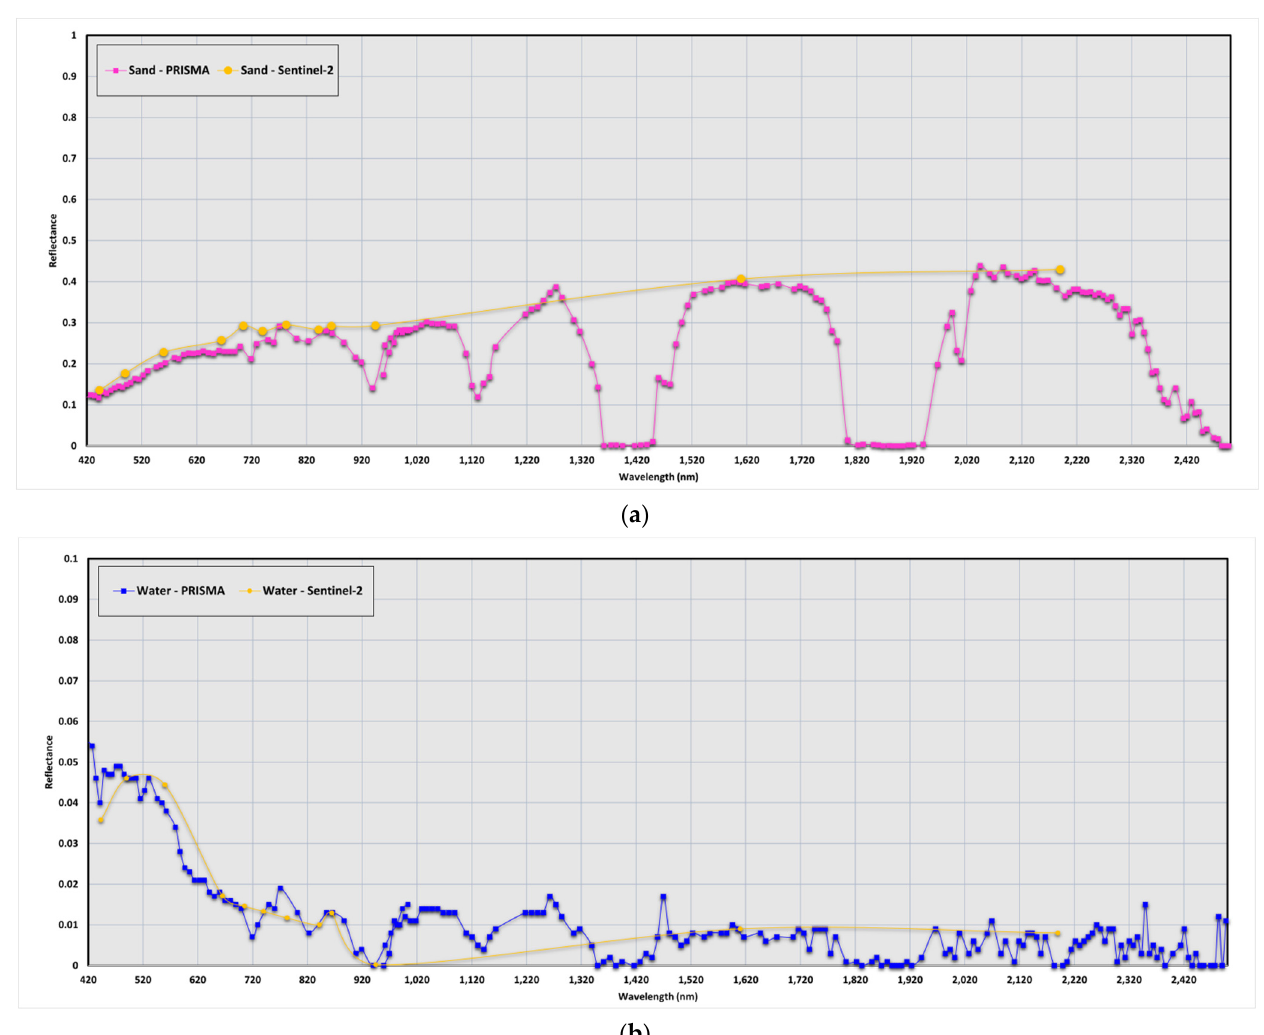
Figure 16. Sinuessa PRISMA and Sentinel ‐ 2 spectral signatures comparison: ( a ) sand and ( b ) water. The y ‐ axe, differently from the previous ones, is between 0 and 0.1, in order to better appreciate the two signatures.